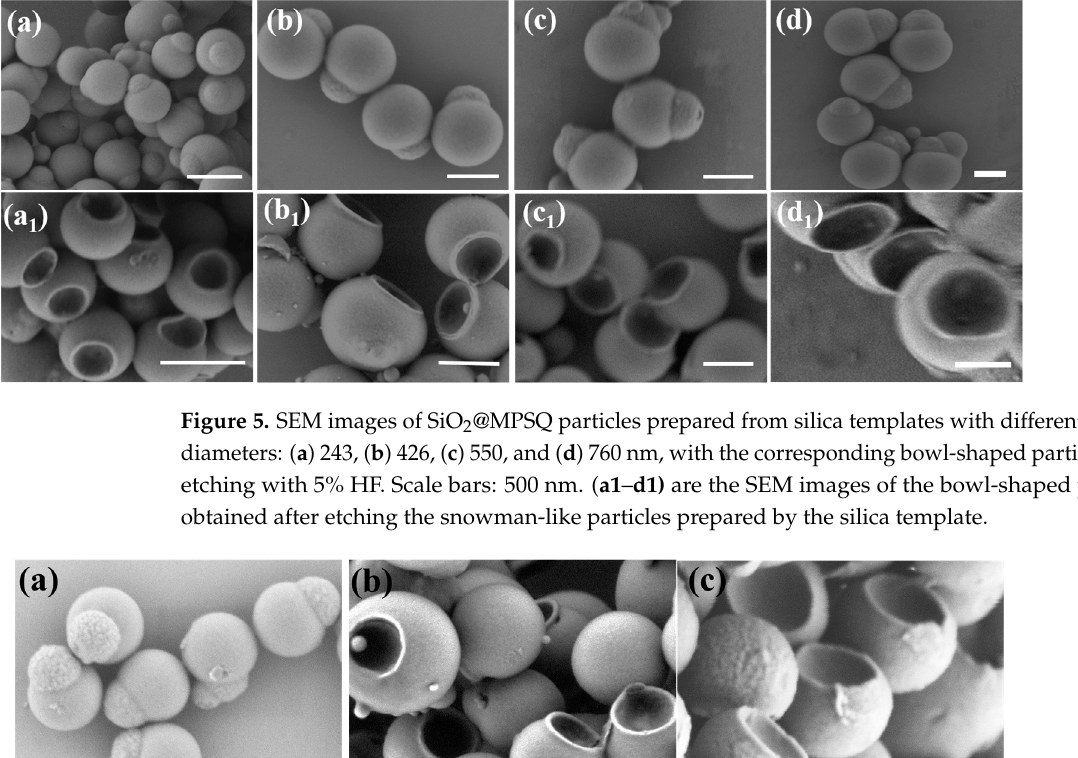
Figure 5. SEM images of SiO 2 @MPSQ particles prepared from silica templates with different particle diameters: ( a ) 243, ( b ) 426, ( c ) 550, and ( d ) 760 nm, with the corresponding bowl-shaped particles after etching with 5% HF. Scale bars: 500 nm. ( a1 - d1) are the SEM images of the bowl-shaped parti- cles obtained after etching the snowman-like particles prepared by the silica template.